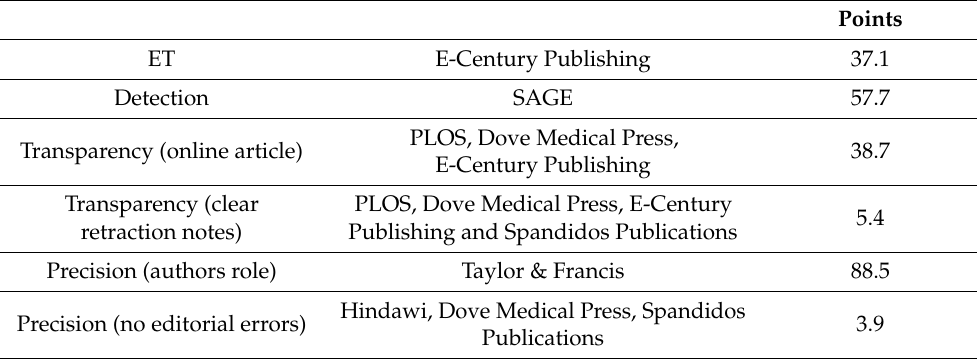
Table 27. Best SDTP score performance 2009–2020.